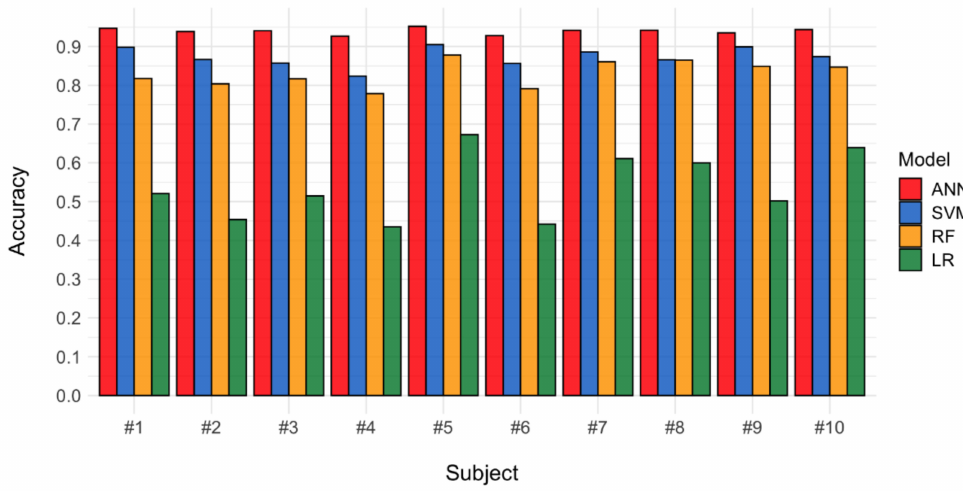
Figure 7. Classifier accuracies for all ten subjects according to the machine learning